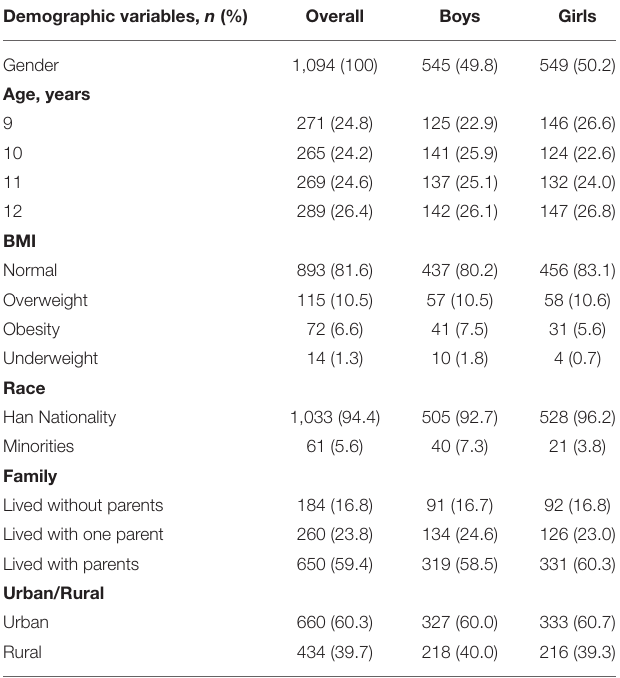
TABLE 1 | Demographic characteristics of the participants. Demographic variables, n (%)